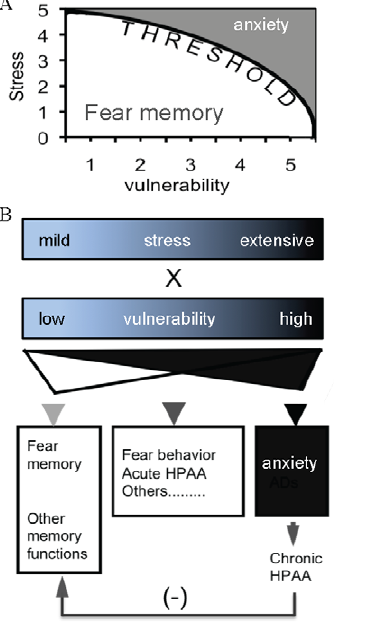
Figure 7. A ‘‘threshold theory’’ for two-behavior system. (A) The expression of a fear phenotype is dependent on both the intensity of stress and degree of vulnerability. There is a linear relationship between these two factors in the pathogenesis of anxiety. (B) The direction of the development of fear behavior is dependent on the integrative force of the interactions between stress and vulnerability. A lower force leads to fear memory, which is accompanied by many adaptive responses such as acute HPA axis response. An extremely higher force leads to anxiety or anxiety-like behavior, which is accompanied by many maladaptive responses including chronic activation of the HPA axis system and many others.